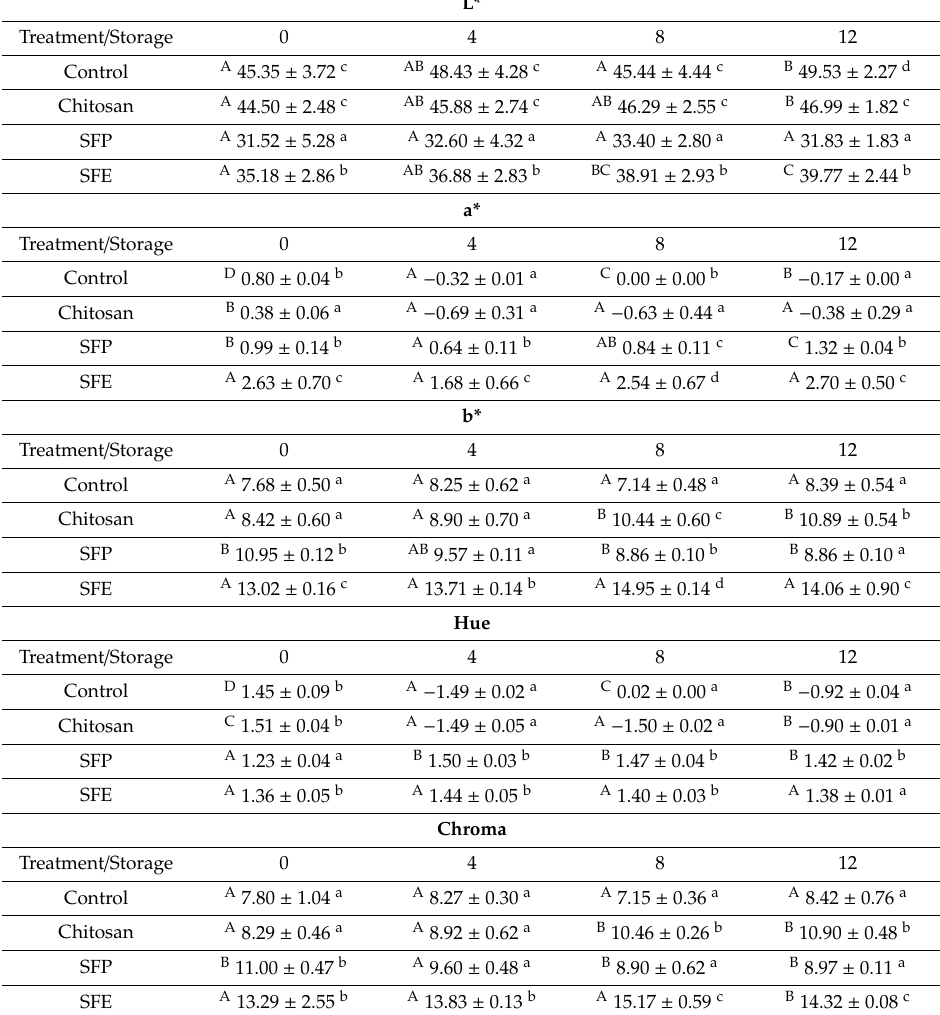
Values (mean ± standard deviation, n = 3) followed by a di ff erent uppercase letter in the same row are significantly di ff erent ( p < 0.05). Values (mean ± standard deviation, n = 3) followed by a di ff erent lowercase letter in the